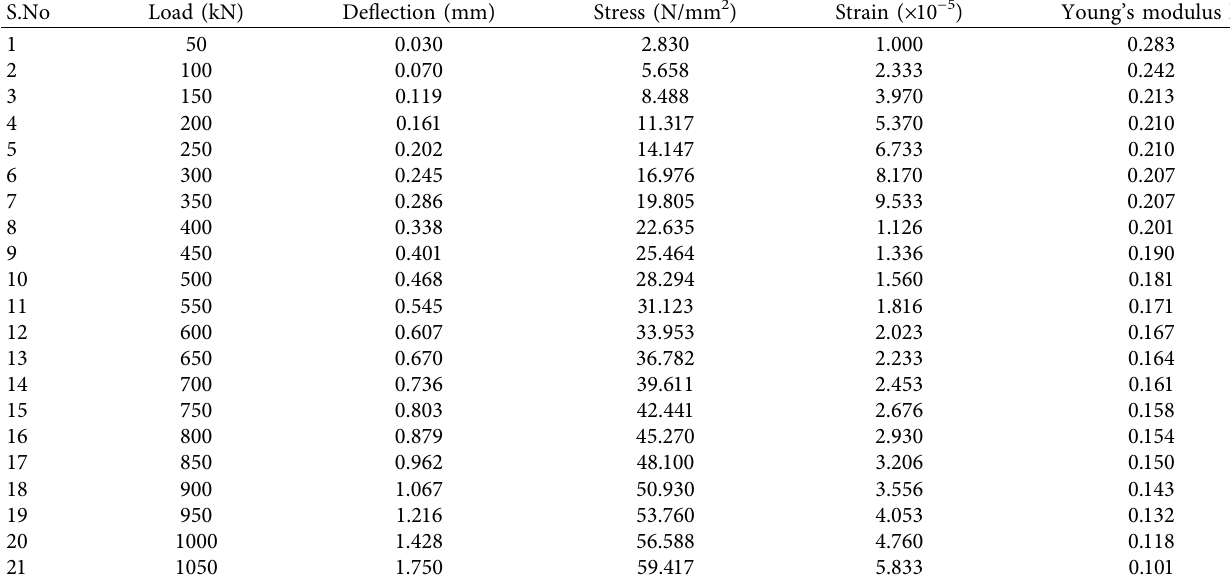
Table 8: Young’s modulus for M40 grade of column with 3mm wrapping.